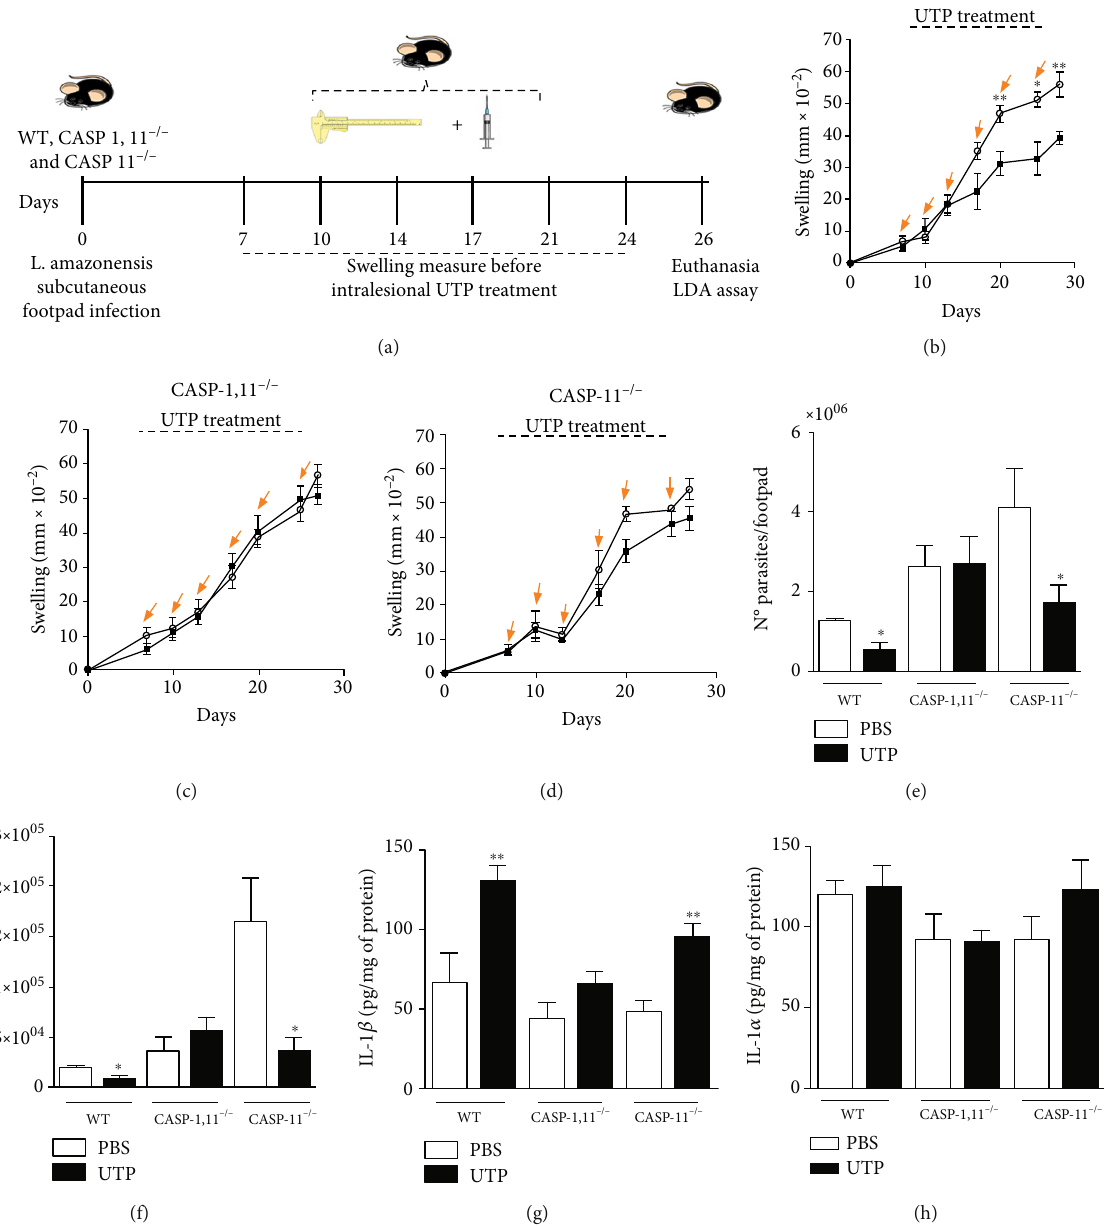
Figure 5: CASP-1 activity is necessary for the protective e ff ects of UTP during in vivo infection with L. amazonensis . (a) Schematics showing the experimental approach of in vivo experiments. WT, CASP-1,11 -/- , and CASP-1,11 -/- mice ( n = 5 and 6/group) were infected with 10 6 L. amazonensis ; following 7d.p.i., we started the intralesional treatment with 1mM UTP into the infected footpad twice a week for 3 weeks (six doses). (b – d) Swelling (thickness) was measured using a traditional Mitutoyo® caliper, and the lesion size was determined by the thicknessof theinfected footpad − thicknessof the uninfected footpad from the same mouse. (e – h) Animals were euthanized 26d.p.i. when the footpad and popliteal lymph nodes were excised and used to quantify parasite load and cytokine production. (e) Parasite loads in the footpads (f) and in popliteal lymph nodes from WT and CASP 1,11 -/- mice by limiting dilution assay (LDA). (g) IL-1 β and (h) IL-1 α production into the footpad was measured by ELISA. Data represent mean ± SEM values, n = 5 – 6 mice per group. ∗∗ P < 0 : 01 and ∗ P < 0 : 05 in comparison to the untreated group (one-way analysis of variance followed by Tukey ’ s